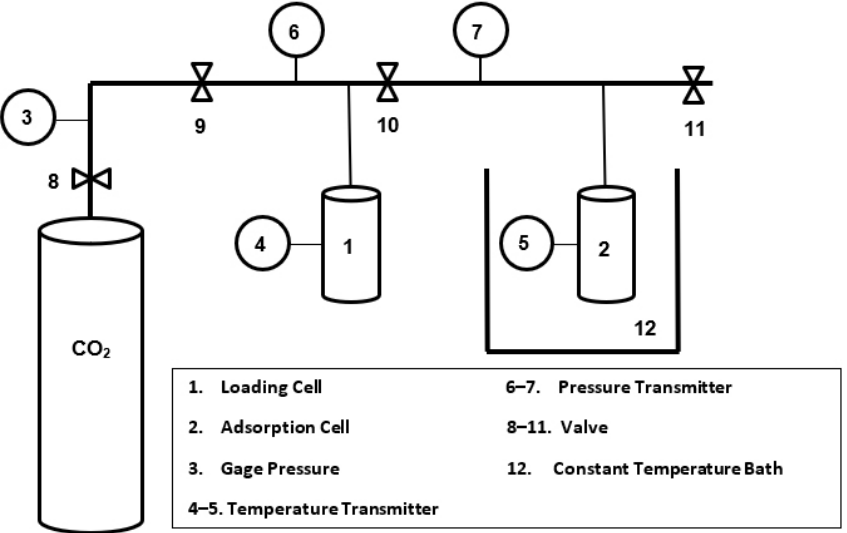
Figure 2. Experimental setup for CO 2 adsorption evaluation.